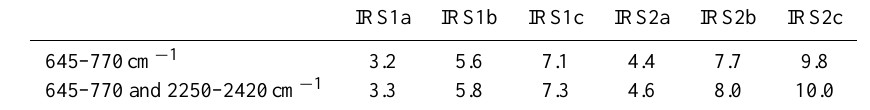
Table 2. Number of degrees of freedom for the retrieval of temperature profile for the eight scenarios, using all the channels located in the 645–770cm − 1 range, or a combination of both the 645–770 and the 2250–2420cm − 1 ranges.